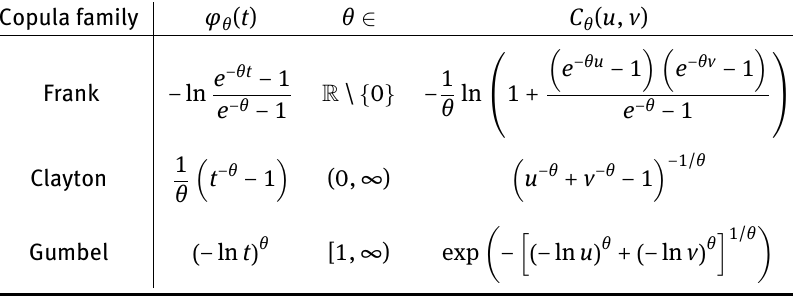
Figure 3: Scatter plots of random samples of size 1000 from the copula based on the mixture of two bivariate elliptical distribu- tions with ( τ G , τ t ) = (0.25, 0.75) , (0.75, 0.25) , (0.25, 0.5) and (0.75, 0.5) (from left to right). Table 1: Summary of generators, parameter ranges and explicit expressions for the bivariate Frank, Clayton and Gumbel copula. Copula